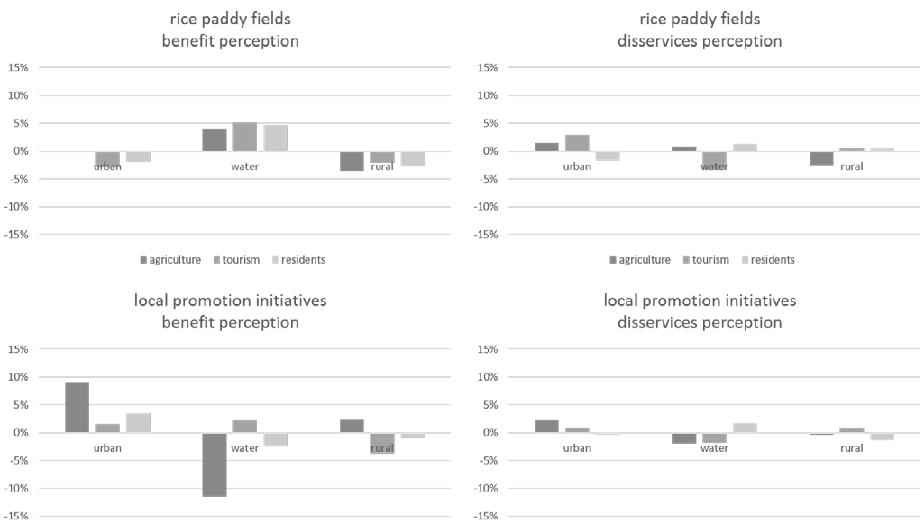
Figure 5. perceived benefits from rice paddy fields and local promotion initiatives. Results are pre- sented as gap (%) from total average for cases living close to urban areas, water elements and rural